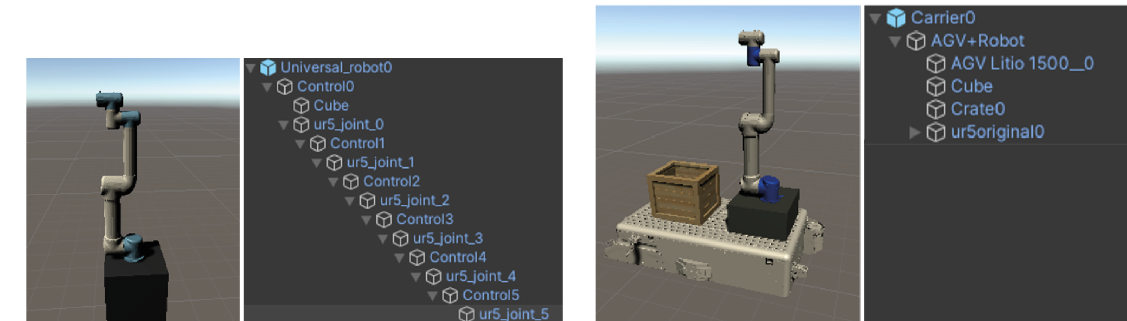
Figure 8. Three-dimensional model of aggregated GameObjects, with the corresponding nested hierarchy.Left: example of a robot arm; right: example of a